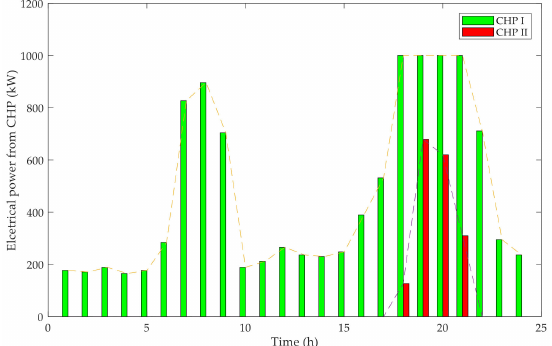
Figure 16. Electrical power supply from CHP_I and CHP_II in Case 2.